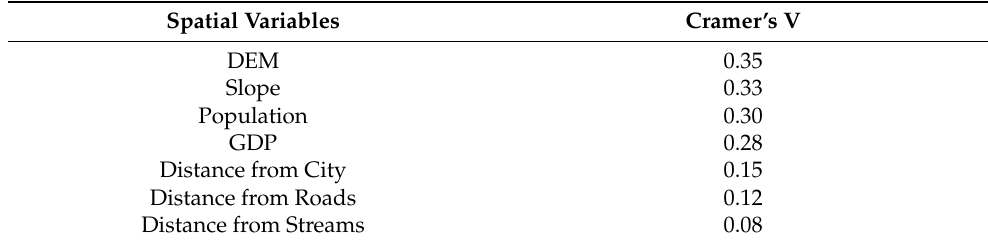
Table 14. Cramer’s V value of spatial variables.